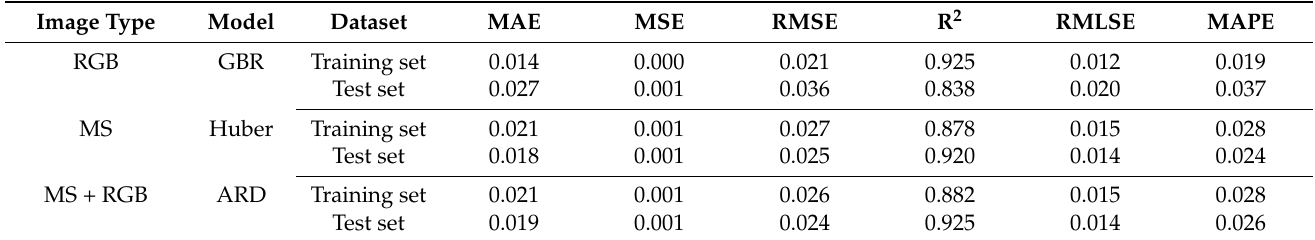
Table 12. Hyperparameter optimization of the highest accuracy model in three image